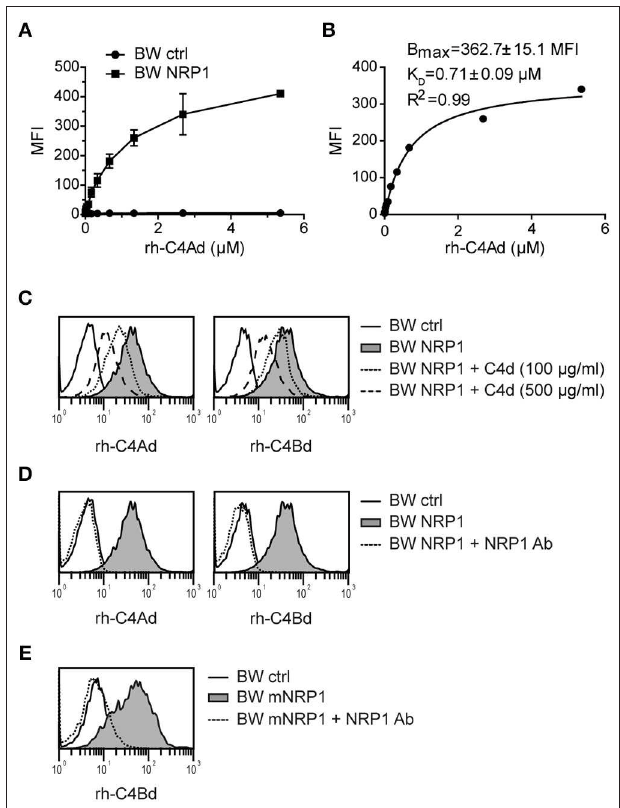
FIGURE 3 | Classical receptor-ligand interaction between C4d and NRP1. (A) BW NRP1 cells or BW control cells were incubated with increasing concentrations of rh-C4Ad. Cell-bound rh-C4Ad was measured by flow cytometry using a monoclonal C4d antibody for detection. Mean and standard deviation of triplicate measurements are shown. (B) Dissociation constant (K D ) of the C4d-NRP1 interaction was assessed via Langmuir binding isotherm equation for single class 1:1 binding equilibrium based on data shown in A . Error estimates of the fitted parameters to the mean of triplicate data points, and the correlation coefficient of the fit to the model are indicated. (C,D) Binding of biotinylated rh-C4Ad or rh-C4Bd (20 µ g/ml each) to BW control cells or BW NRP1 in absence or presence of unlabeled rh-C4d (C) or a polyclonal NRP1 antibody (10 µ g/ml) (D) . (E) Binding of biotinylated rh-C4Bd (20 µ g/ml each) to BW control cells or BW mNRP1 in absence or presence of a polyclonal NRP1 antibody (10 µ g/ml). In (A–E) probe biotinylation